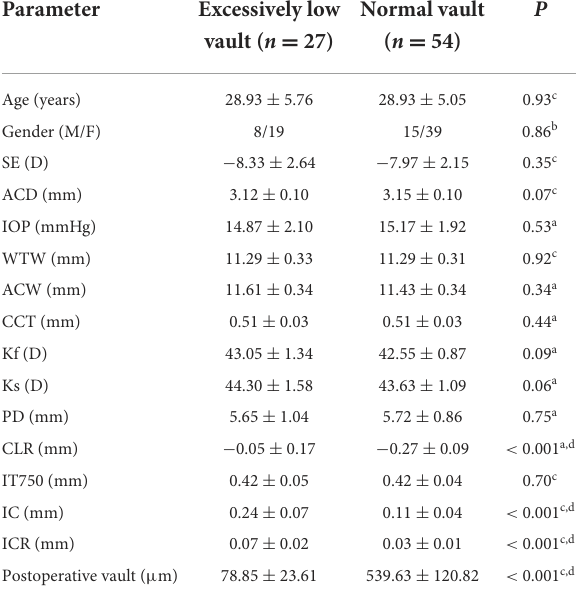
TABLE 1 Comparisons of demographics and ocular biometric parameters of patients between the excessively low vault and normal vault